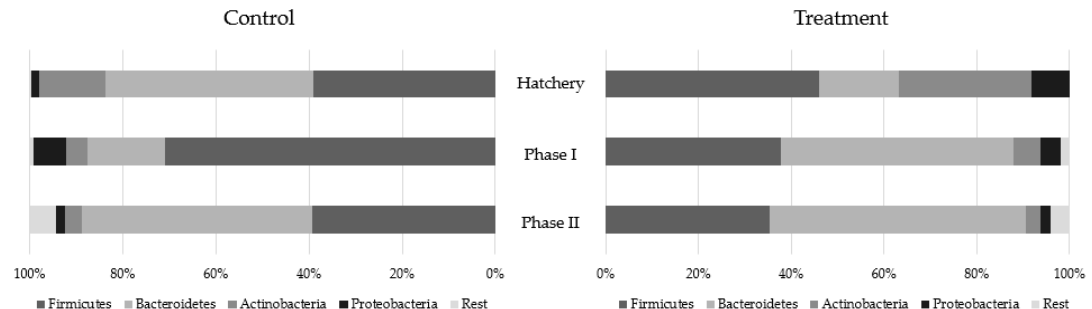
Figure 3. Metagenomic results. Phyla distribution by groups over time. Hens showed a higher relative abundance (RA) of Actinobacteria, Firmicutes and Proteobacteria in FDA-supplemented group (treatment) compared to control in hatchery. In phase I, the RA of Actinobacteria and Bacteroidetes was higher in the FDA group. In phase II, the RA of Bacteroidetes and Proteobacteria was higher in the treated group.